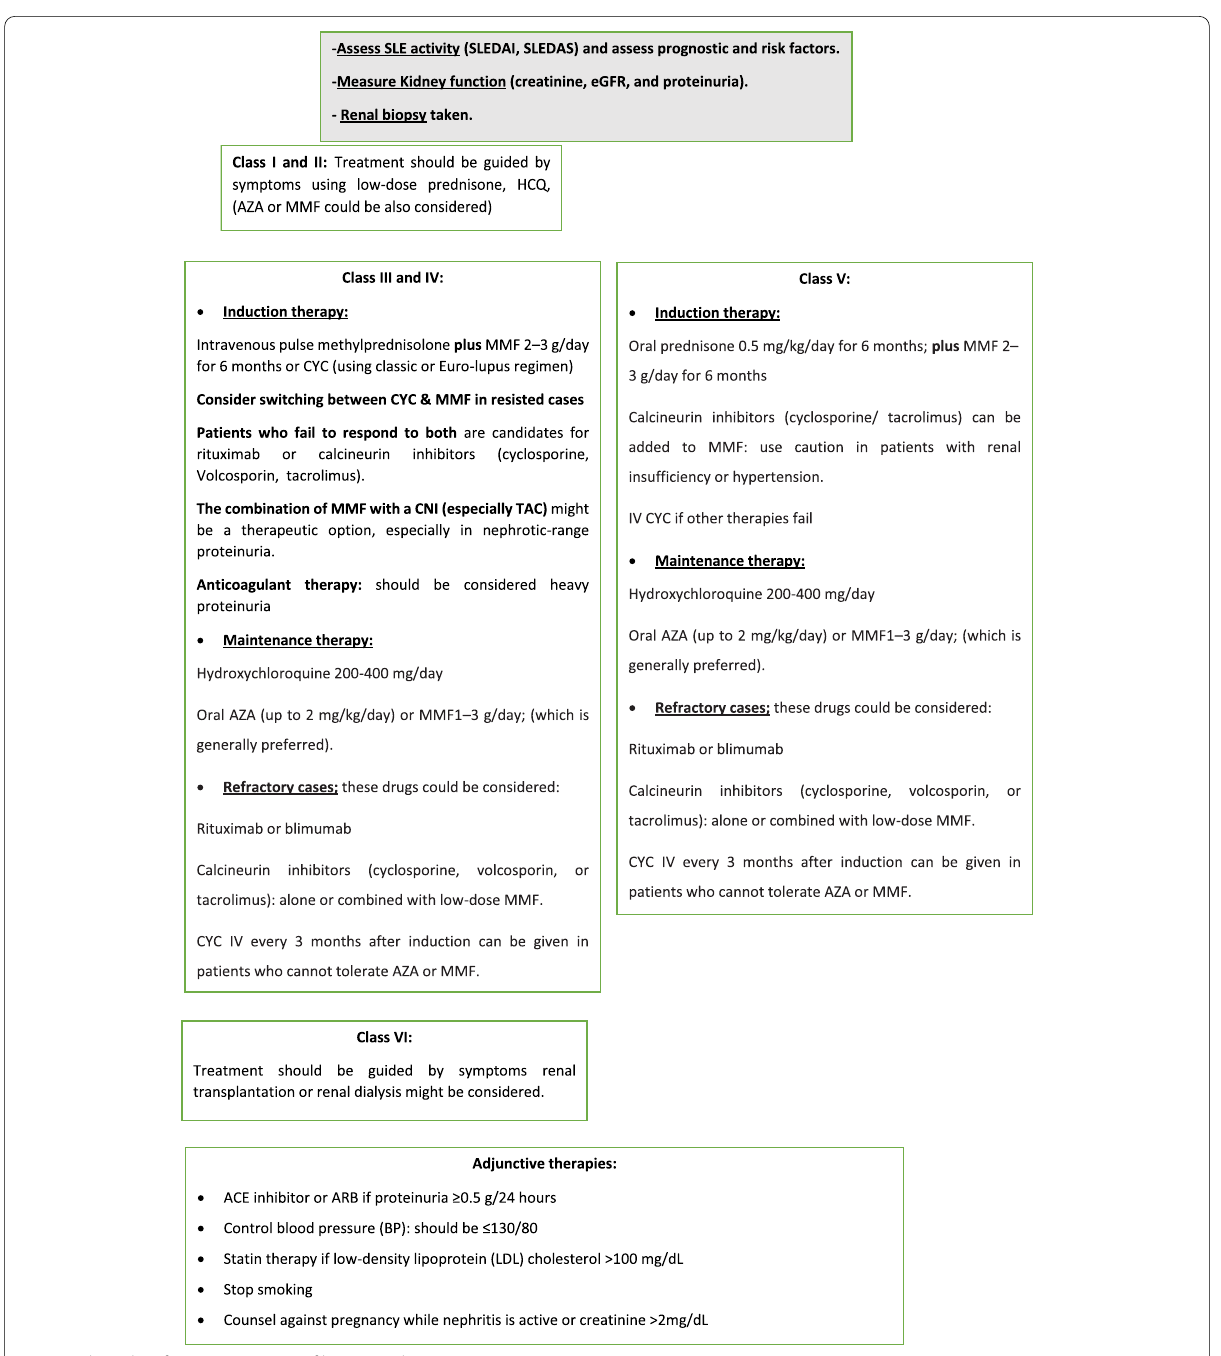
Fig. 2 Algorithm for management of lupus